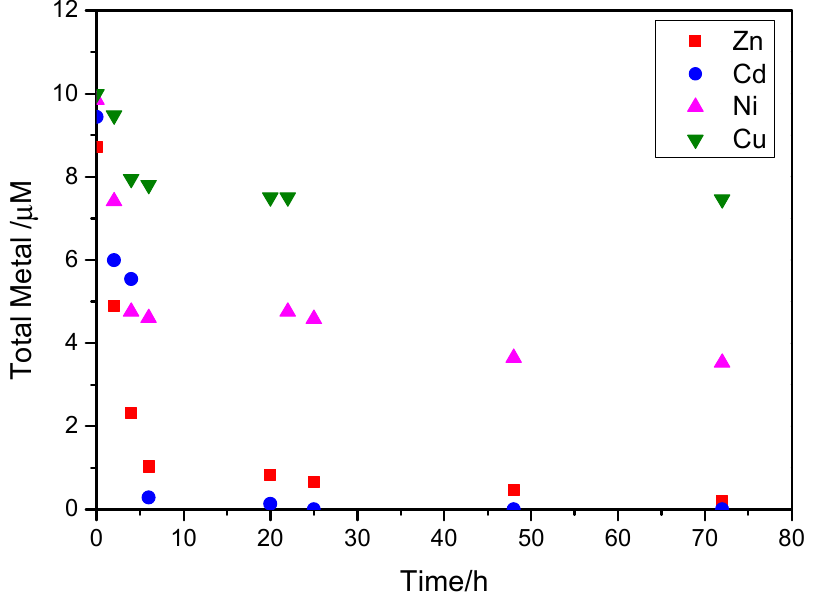
Figure 13. Concentration of Zn, Cd, Ni and Cd in the supersaturated solutions during precipitation of calcium carbonates, a function of time, in the presence of 20 mL of active A. obliquus culture, under illumination; SR calcite = 14.79, 25 ◦ C, pH 8.50, 0.15 M of